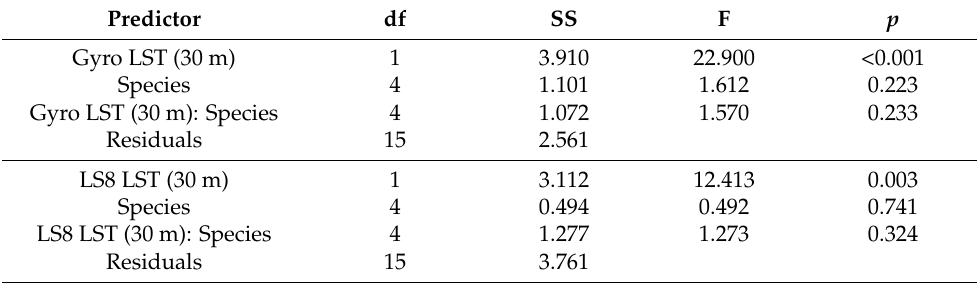
Figure 9. ( a ) Observed species-specific differences obtained from gyrocopter LST data with a pixel size of 30 m in comparison to ( c ) the downscaled Landsat 8 product. Results from the SAC model showing a pairwise comparison of fine scale tree species surface temperatures, as obtained from the SAC model using ( b ) gyrocopter LST data aggregated to a pixel size of 30 m and ( d ) the downscaled Landsat 8 product data. Reference species at the x -axis—higher temperatures of tested species compared to the reference species in red, lower temperatures in blue. The diameter of circles is related to the magnitude of species difference in ◦ C, and the color gradient indicates the level of significant species differences (n.s. p > 0.05, * p < 0.05, ** p < 0.01, *** p < 0.001). Table 4. ANOVA table for the regression models testing gyrocopter LST at 30 m resolution or the downscaled Landsat 8 and tree species identity, and their interaction, to predict air temperatures at the tree crown level; df = degrees of freedom, SS = sum of squares, F = F-value, p = p